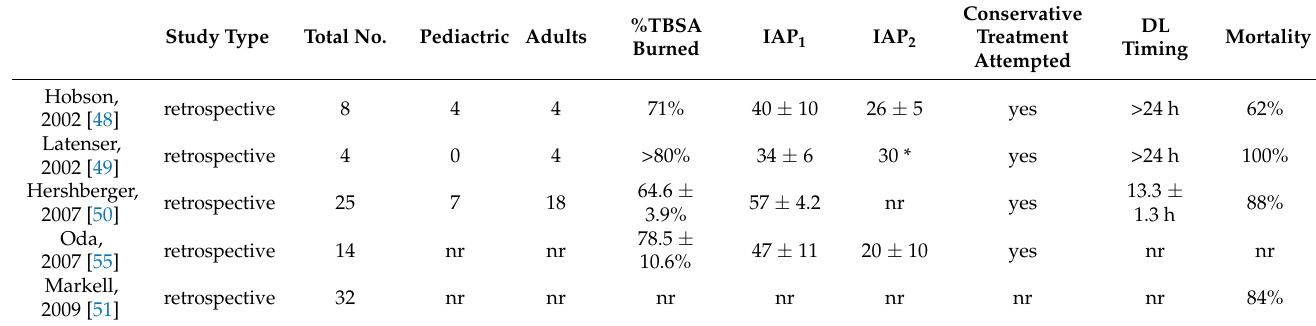
Table 3. Abdominal compartment syndrome in the context of burns. ACS—abdominal compartment syndrome; IAP1— intra-abdominal pressure before decompression laparotomy; IAP2—intra-abdominal pressure after decompression;